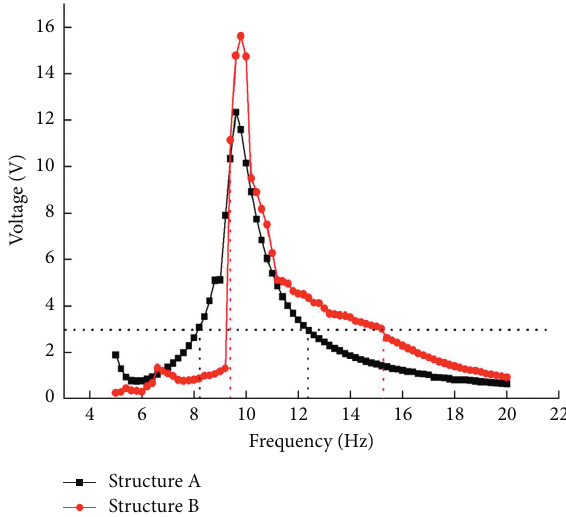
Figure 8: Relation of the frequency-voltage of the structure A and the structure B is given when the initial magnetic distance of the structure B is 15 mm.